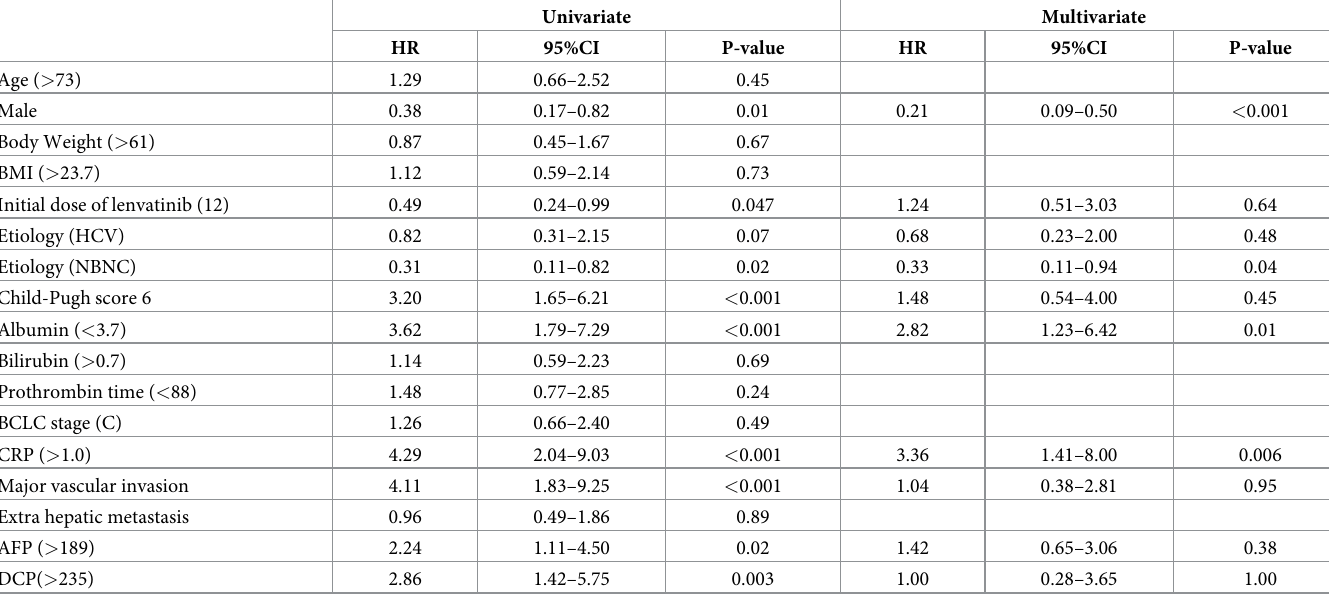
weeks, respectively. The median time to decompensation did not differ between the two Table 3. Univariate and multivariate analysis to determine the factors associated with TTF.